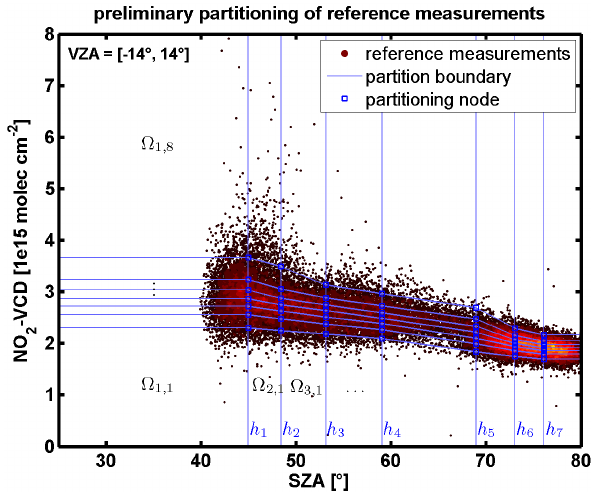
Fig. A1. Preliminary partitioning ( N ϑ ,N V = 8) of GOME-2 refer- ence measurements (color-coded density) for the near-nadir direc- tion ( | ψ | ≤ 14 ◦ ) whose final partitioning is shown in Fig.